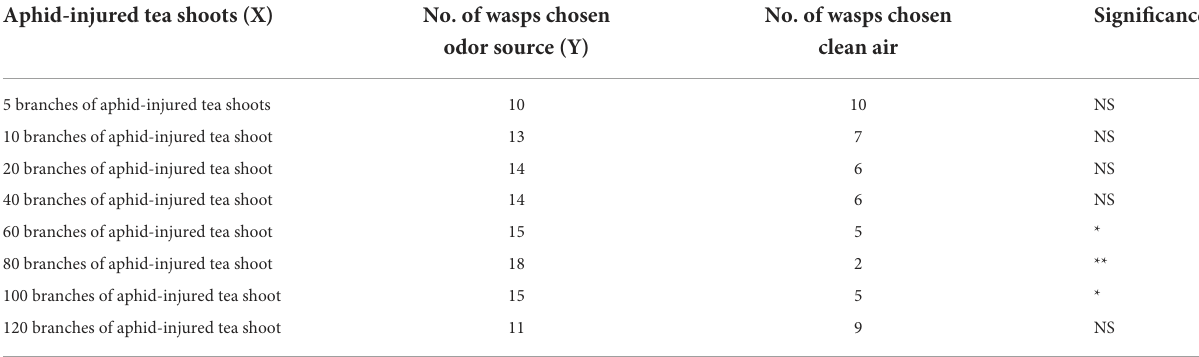
TABLE 3 Number of Aphelinus sp. attracted to aphid-injured tea shoots vs. clean air in Y-tube olfactometer assay. Aphid-injured tea shoots (X) No. of wasps